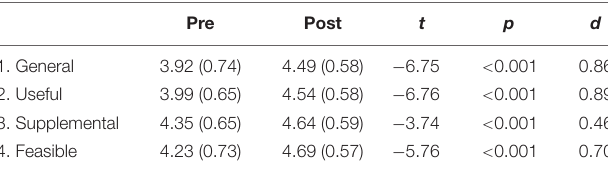
TABLE 4 | Clinicians’ attitudes to using VRET pre- and post-intervention ( n =